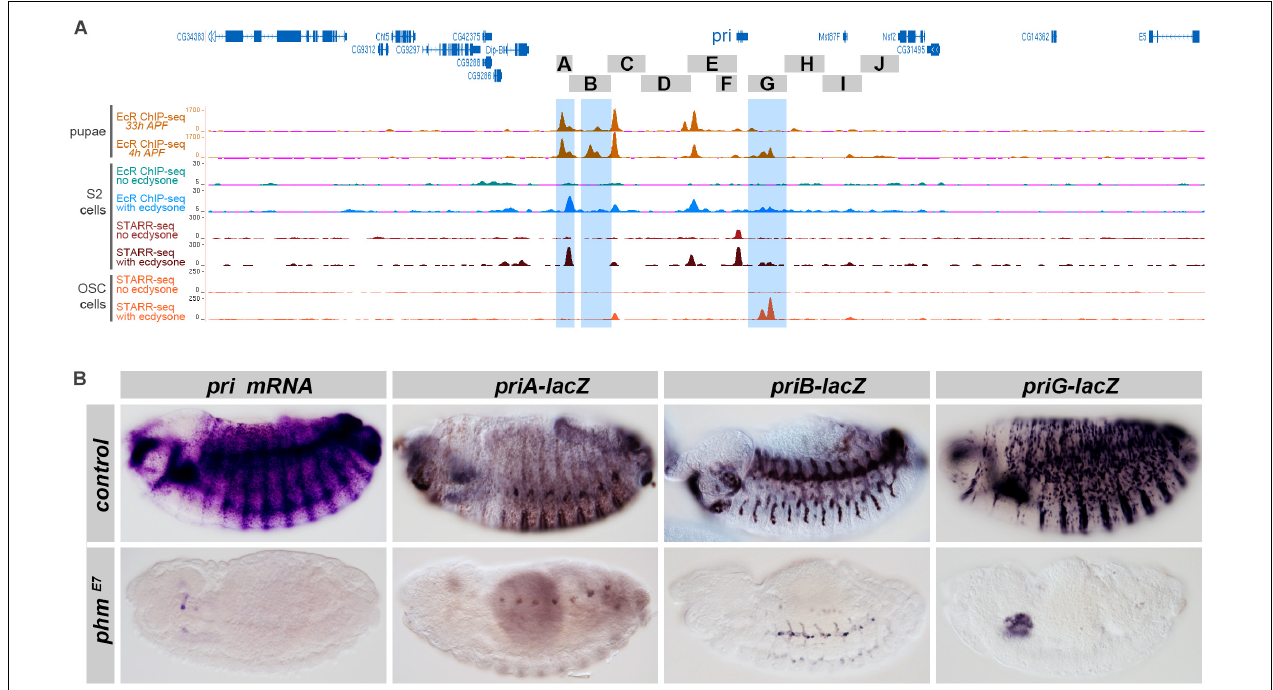
FIGURE 4 | Ecdysone controls pri expression and the activity of embryonic enhancers. (A) Genome browser snapshot of the genomic region encompassing the pri locus; pri regions tested in transgenic lacZ-reporter lines are drawn as gray boxes. The different tracks represent signal intensity profiles of in vivo EcR ChIP-Seq [4 and 33 h after puparium formation (APF)] in orange (Chanut-Delalande et al., 2014), EcR ChIP-seq in S2 cells with or without ecdysone treatment (blue and green, respectively), STARR-seq profiling of active enhancers with or without ecdysone (brown and dark red) in S2 cells, as well as STARR-seq profiling with or without ecdysone (red) in ovarian somatic cells (OSC) (Shlyueva et al., 2014). (B) Endogenous expression of pri mRNA, and of priA , priB , and priG enhancers, in control conditions and phm E 7 mutant embryos, which are unable to synthesize ecdysone (Warren et al.,